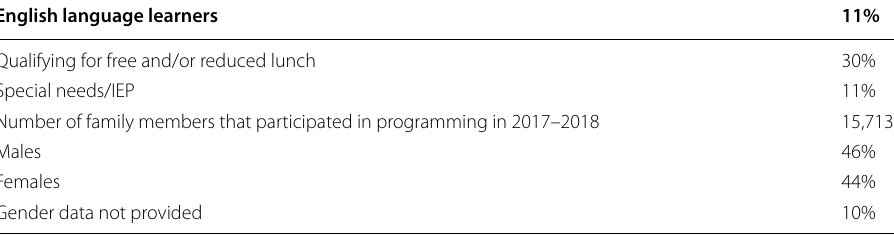
Table 2 Other student characteristics for ALL students served by 21st CCLC in Idaho ( n